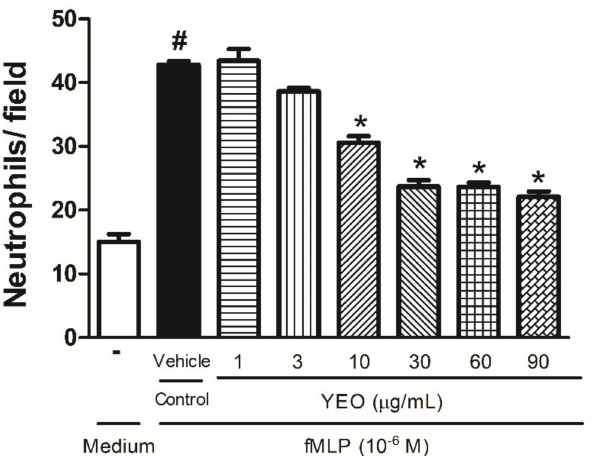
Figure 1. Effect of YEO on in vitro neutrophil chemotaxis. Neutrophils were stimulated with fMLP (10 − 6 M) 30 min after YEO treatments at the concentrations of 1, 3, 10, 30, 60, and 90 µ g/mL. The results are representative of three independent experiments. # p < 0.05 compared to medium, * p < 0.05 compared to the control group (ANOVA, Newman–Keuls test).